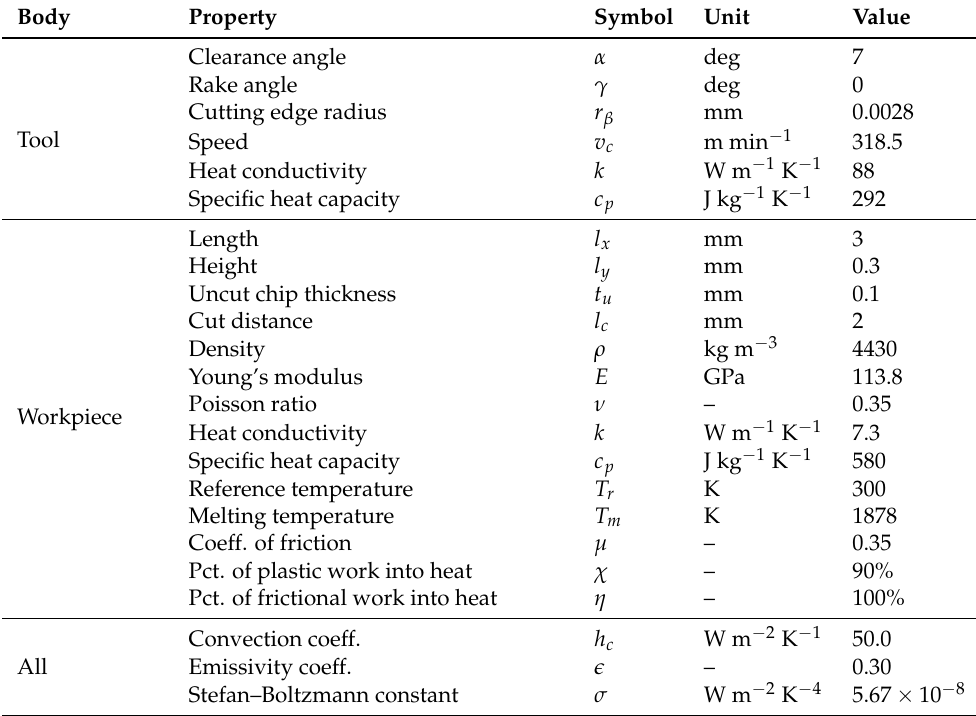
Table 1. Experimental and numerical parameters for the cutting test, according to the works in [17,19]. Thermo-physical properties required for thermal convection and radiation are taken from the works in [38].